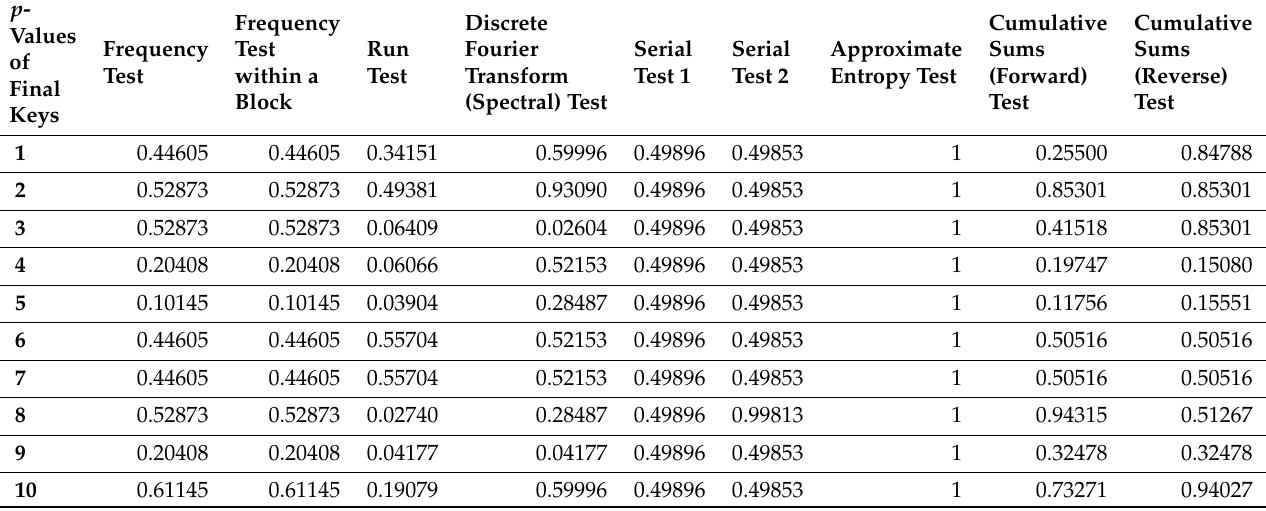
Table 6. p -values of appropriate NIST statistical Tests on Randomness applied to Final Key (mean size = 62 bit) of B92. Conclusion: